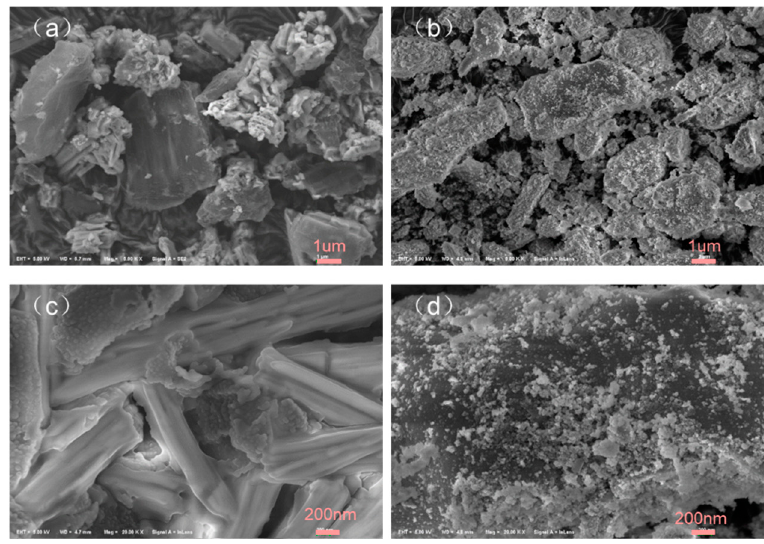
◦ C ( a , c ); after ablation at 1000 ◦ C ( b , d